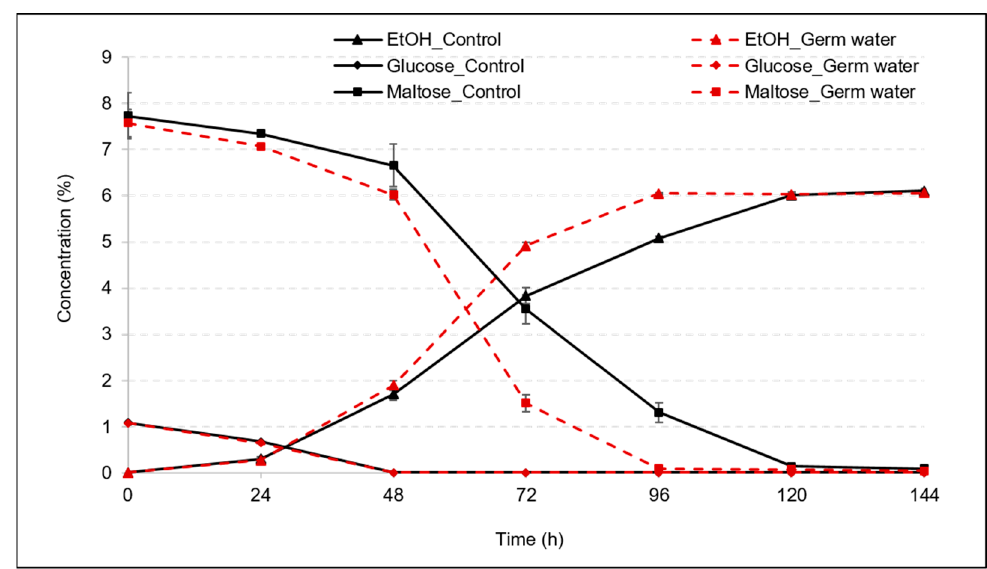
Figure 5. Ethanol (% v/v), glucose (% w/v), and maltose (% w/v) concentrations during fermentation without (control) and with the addition of flint corn germ soak water.